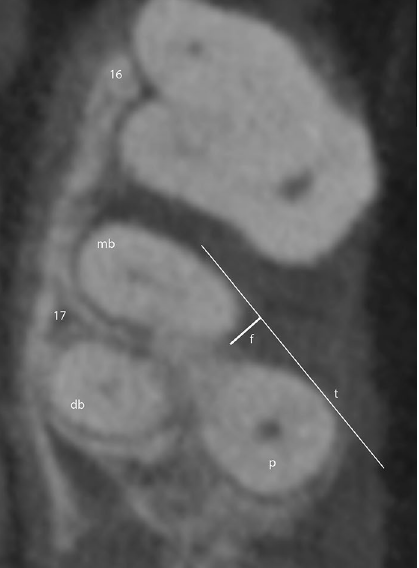
Figure 1. Measurement at the mesiopalatal furcation entrance of tooth 17 in the axial plane. mb mesiobuccal, db distobuccal, p palatinal, t tangent line along the outermost superficial points of the two limiting roots, f distance from the tangent line to the furthest point of the furcation